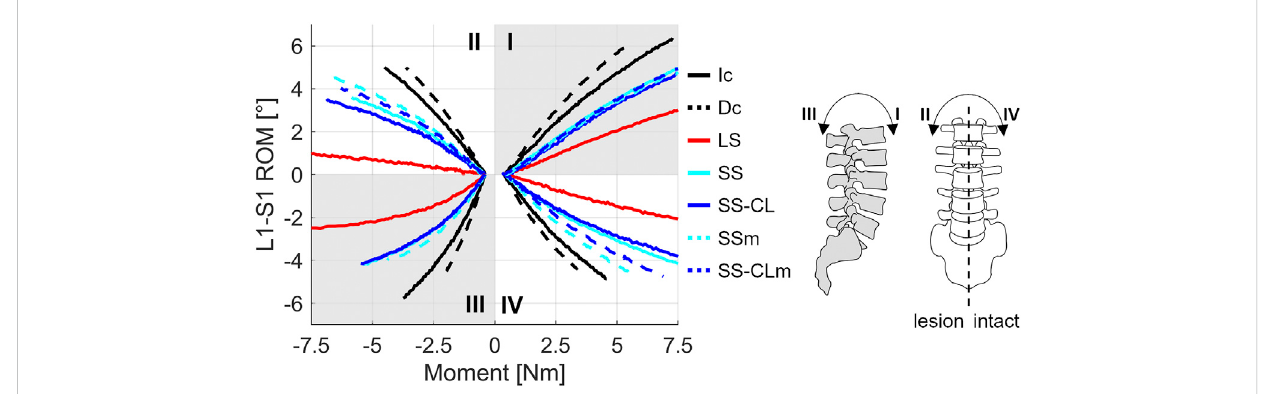
FIGURE 4 Moment vs. Total ROM curves of all the analyzed con fi gurations. Mean values of the three replicas are represented. Each quadrant describes one different bending load: I and III fl exion/extension; II and IV lateral bending.